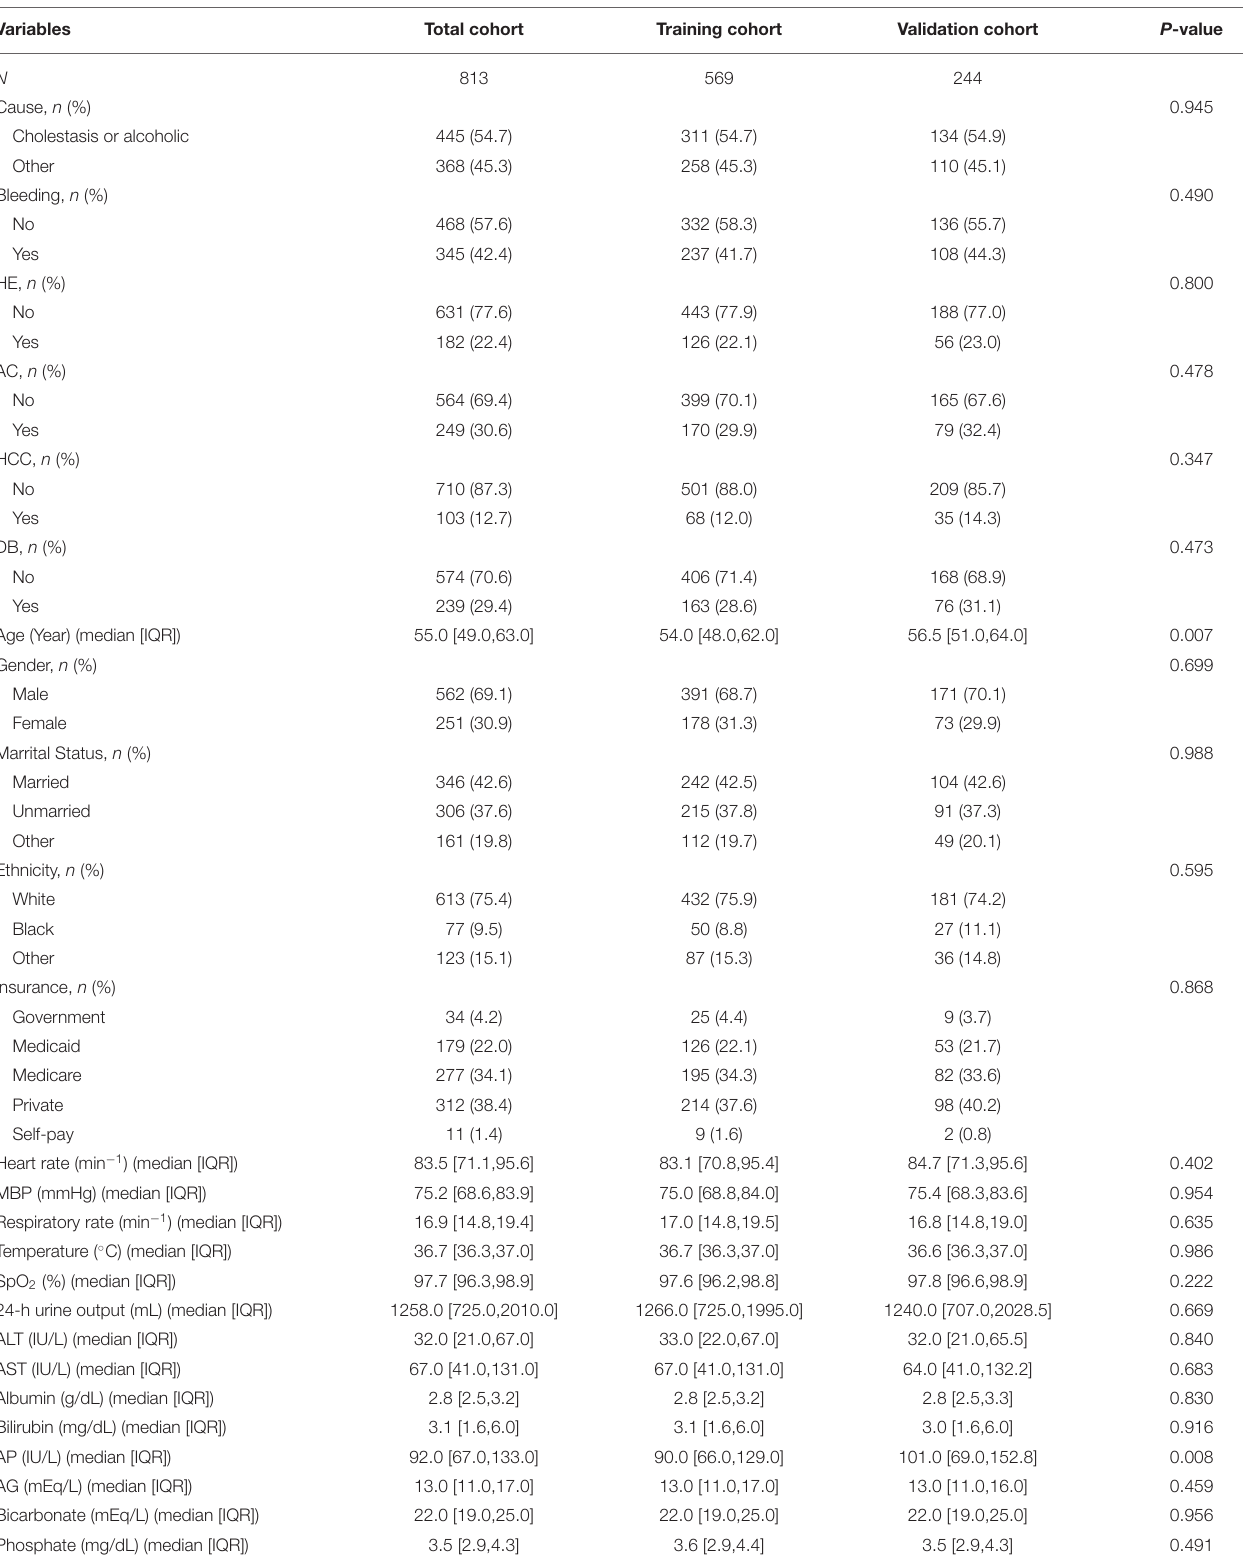
TABLE 1 | Baseline demographic and laboratory characteristics of LCEV patients in MIMIC-III database.